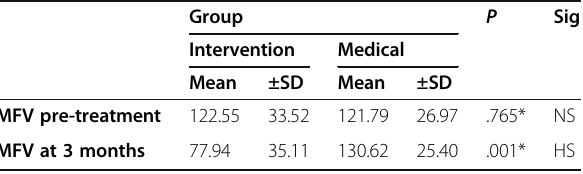
Table 7 MFV of both groups Group P Sig Intervention Medical